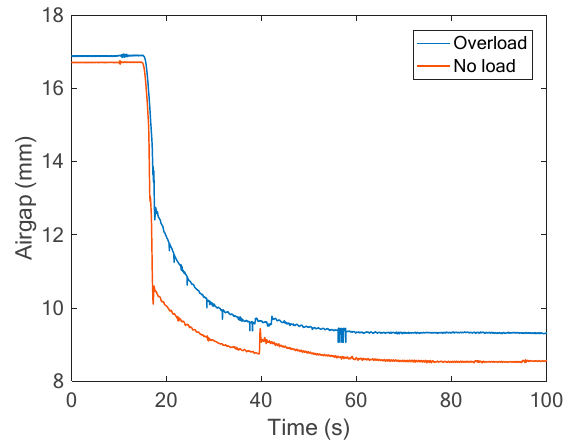
Figure 9. Effect of vehicle load on the airgap.